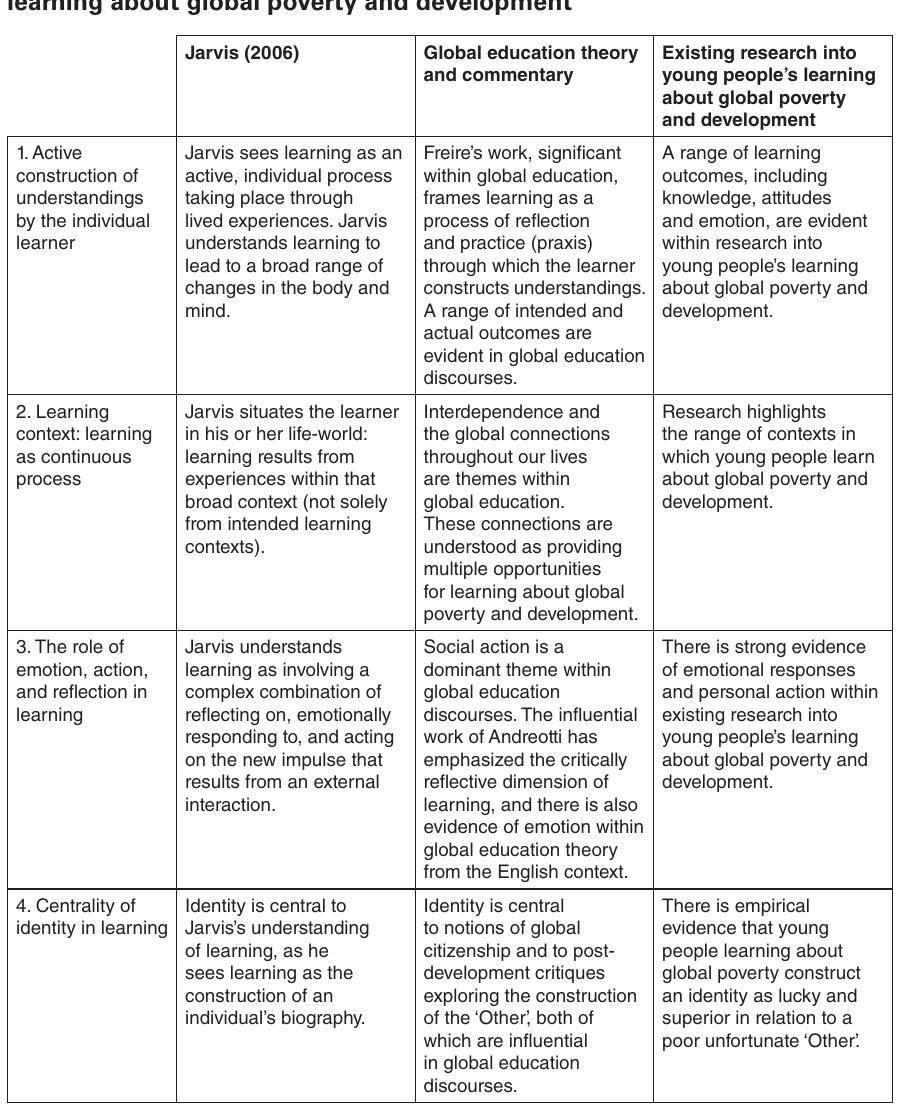
Table 1: Shared themes between Jarvis’s (2006) model of learning process, global education, and empirical research into English young people’s learning about global poverty and